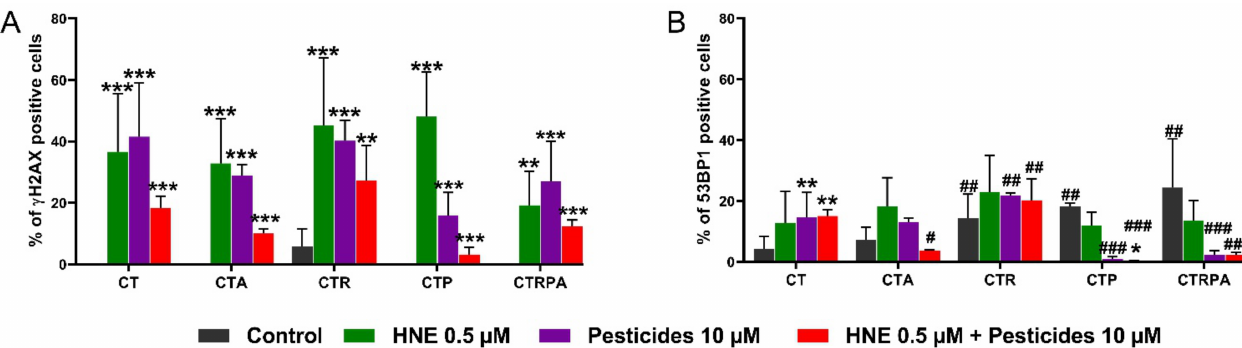
Figure 3. Analysis of DNA damage markers after three weeks exposure in HCECs. ( A ) Quantification of HCECs positives for γ H2AX. No positive cells were observed in the conditions of untreated CT, CTA, CTP and CTRPA. ( B ) Quantification of HCECs positives for 53BP1 after a long-term exposure (3 weeks). Results from ( A , B ) panels represent the mean ± SEM of three independent experiments; statistical differences were analysed by post-hoc tests of a 2-way ANOVA model between control and treated cells (* p < 0.05, ** p < 0.01, *** p < 0.001) or between CT cells and others isogenic HCECs (# p < 0.05, ## p < 0.01, ### p <